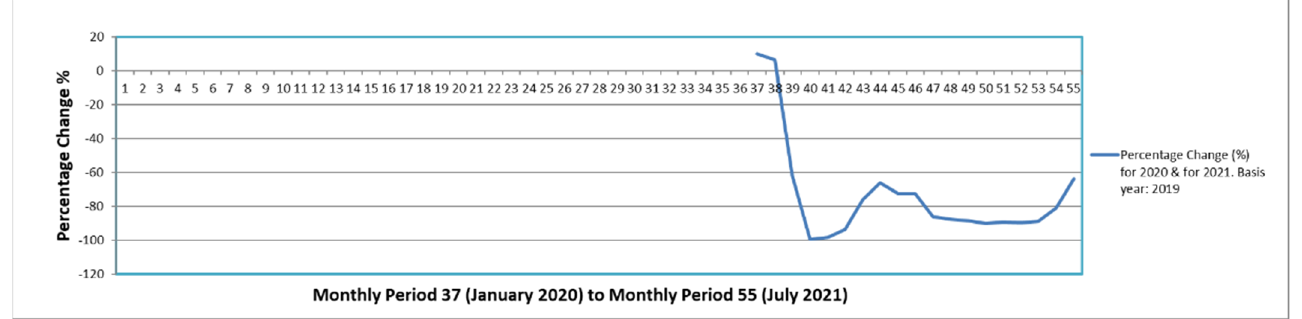
Figure 9. Rate of change for international pax traffic in AIA.